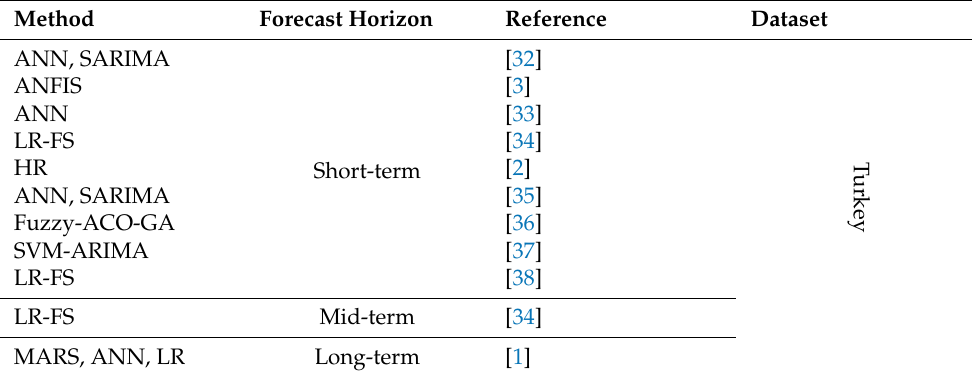
Table 2. Brief representation of some recent studies in forecasting the electricity load of Turkey. Method Forecast Horizon Reference